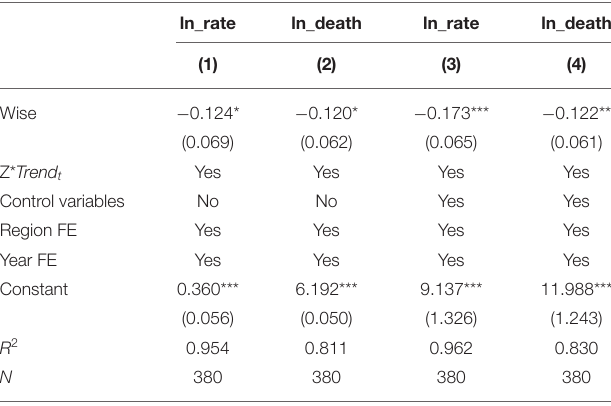
TABLE 6 | Results of controlling inherent differences of a